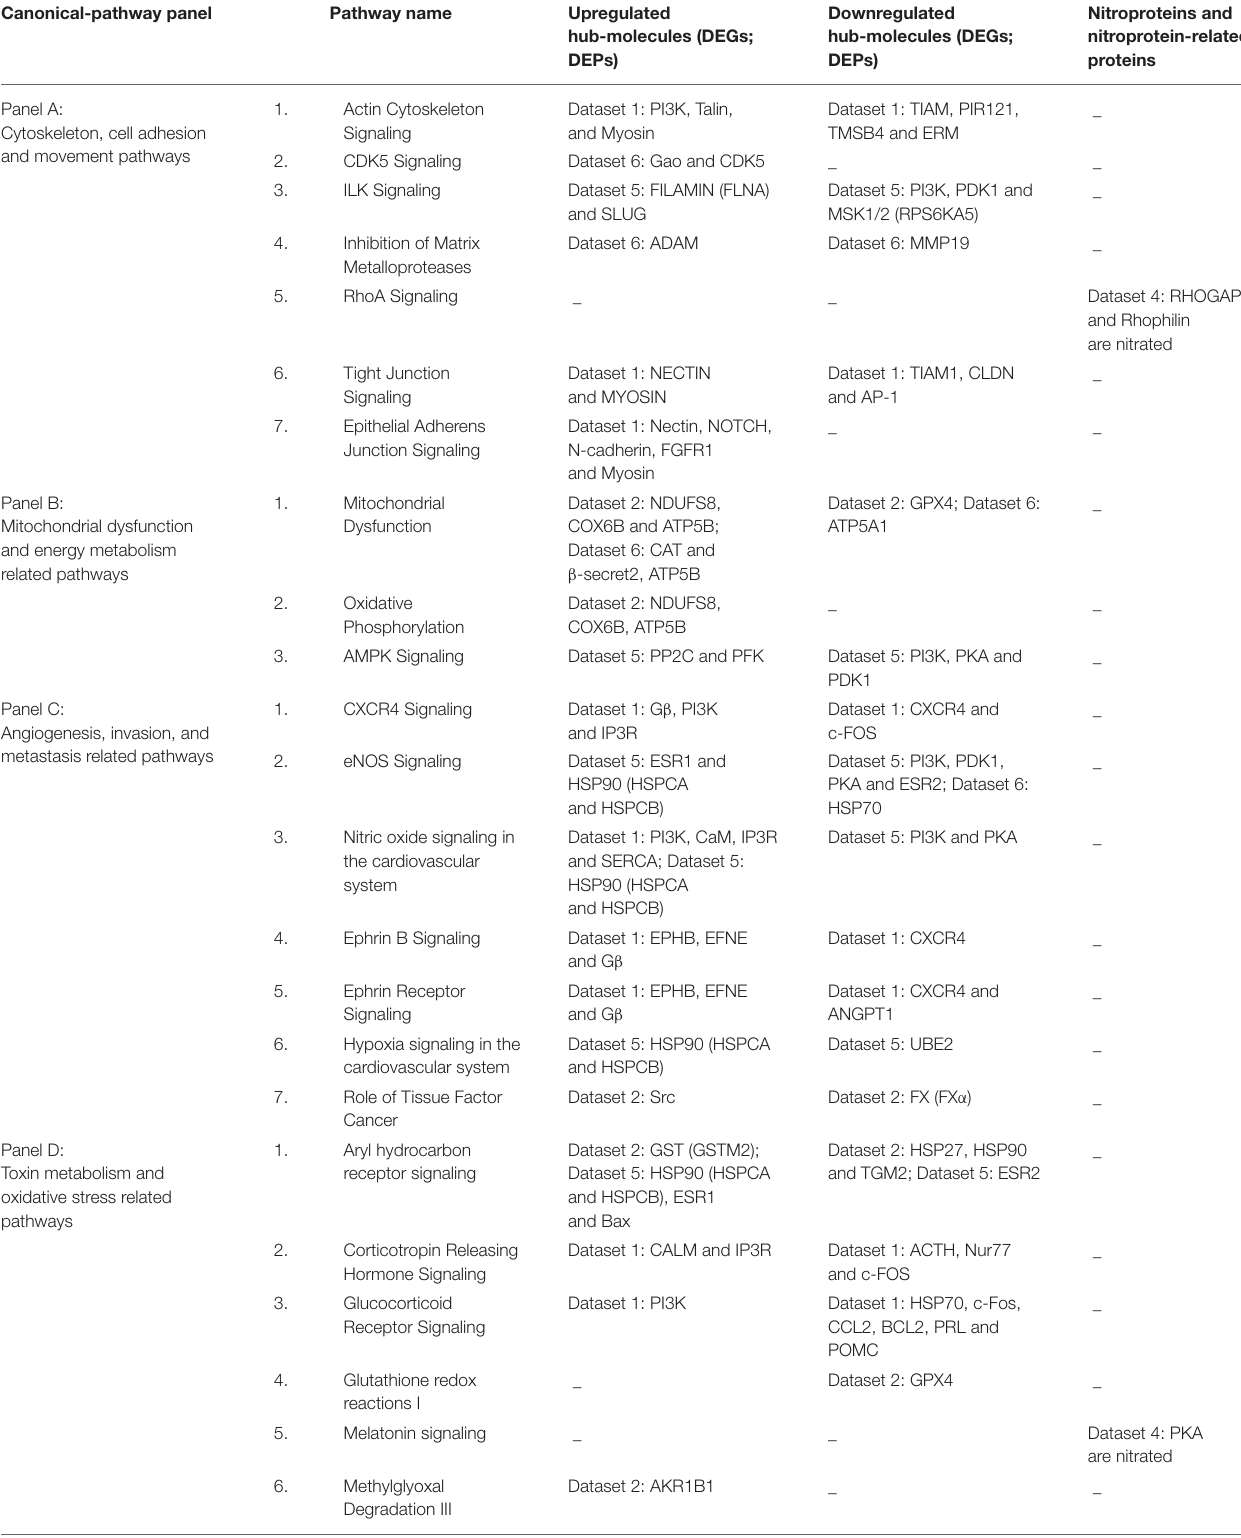
TABLE 2 | Differentially expressed hub-molecules (DEGs, or DEPs) in 54 significantly cancer-related canonical pathways among nine canonical-pathway panels in NFPAs. Canonical-pathway panel Pathway name